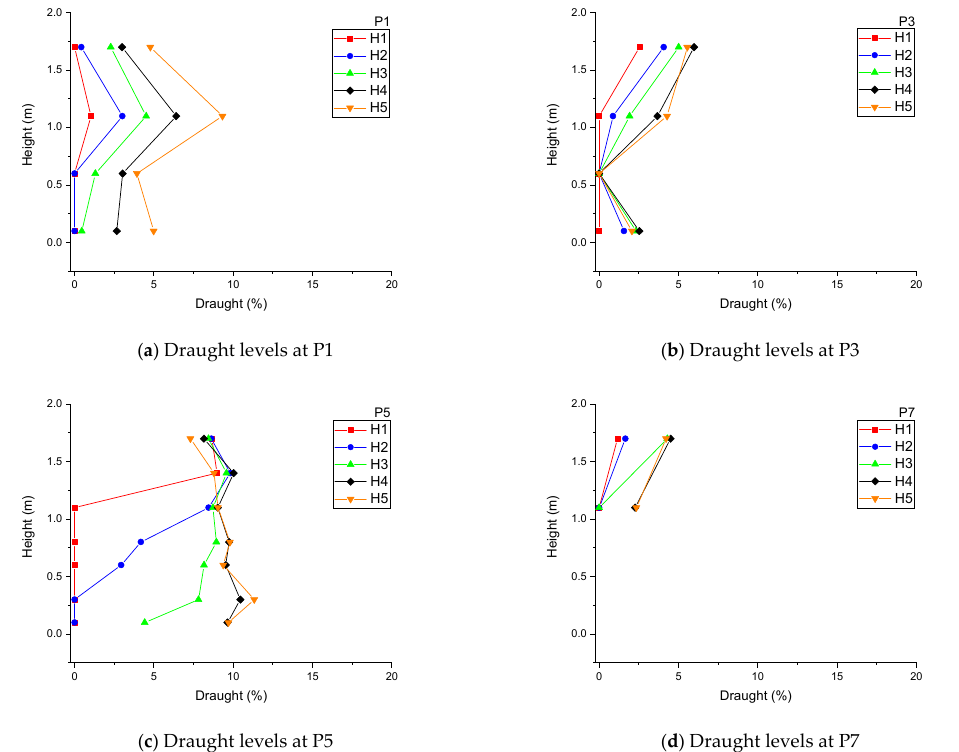
Figure 9. Draught levels at position P1 ( a ), P3 ( b ), P5 ( c ) and P7 ( d ) for heating cases (H1–H5).